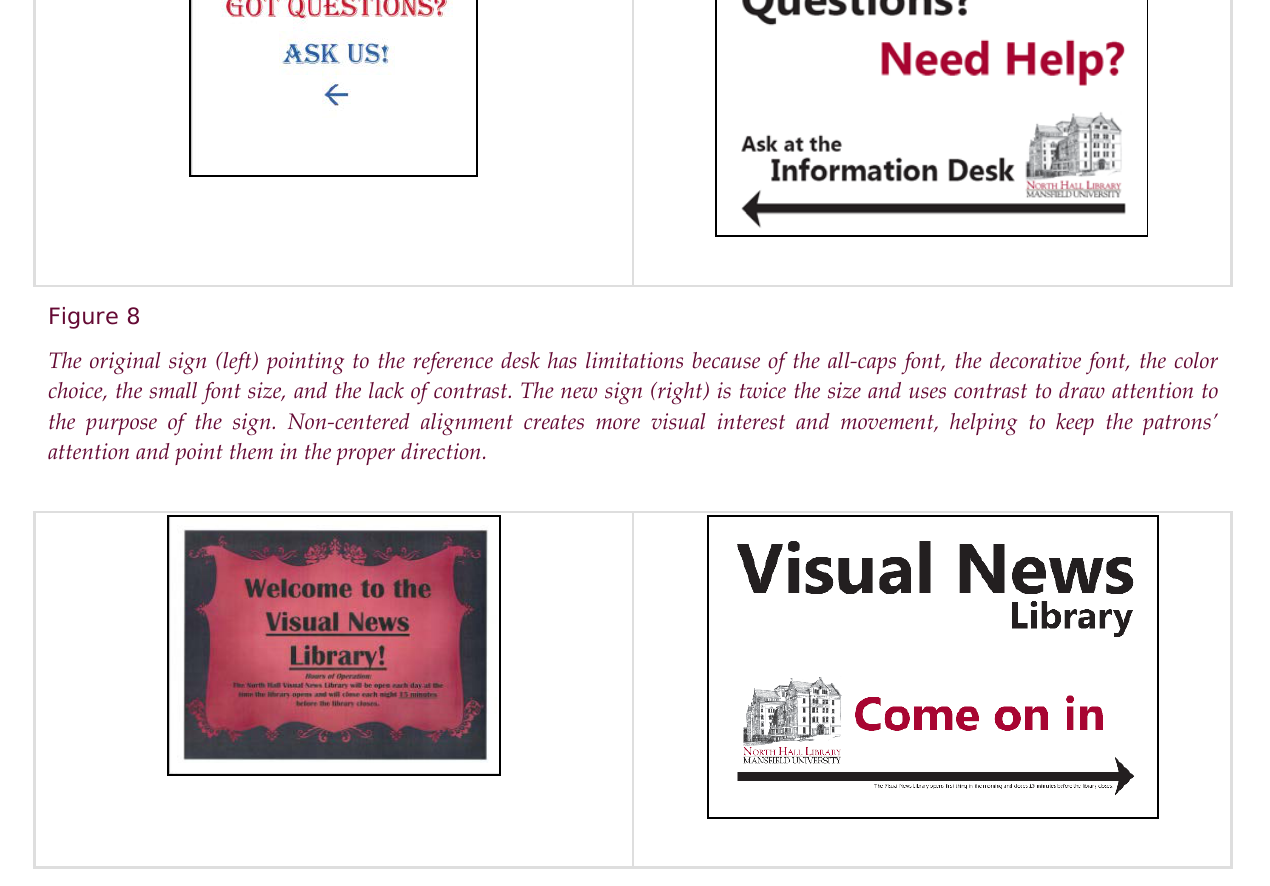
The old sign (left) uses a complex and colored background that does not offer sufficient contrast to be seen from a distance. Some of the text is underlined, but the contrast is not sufficient to draw attention to the name of the room. For the new sign (right), removing the colored background, enlarging the size of the sign, and using font size contrast make it easier to read the sign from a distance. The sign is now visible even from across the open library atrium and one floor